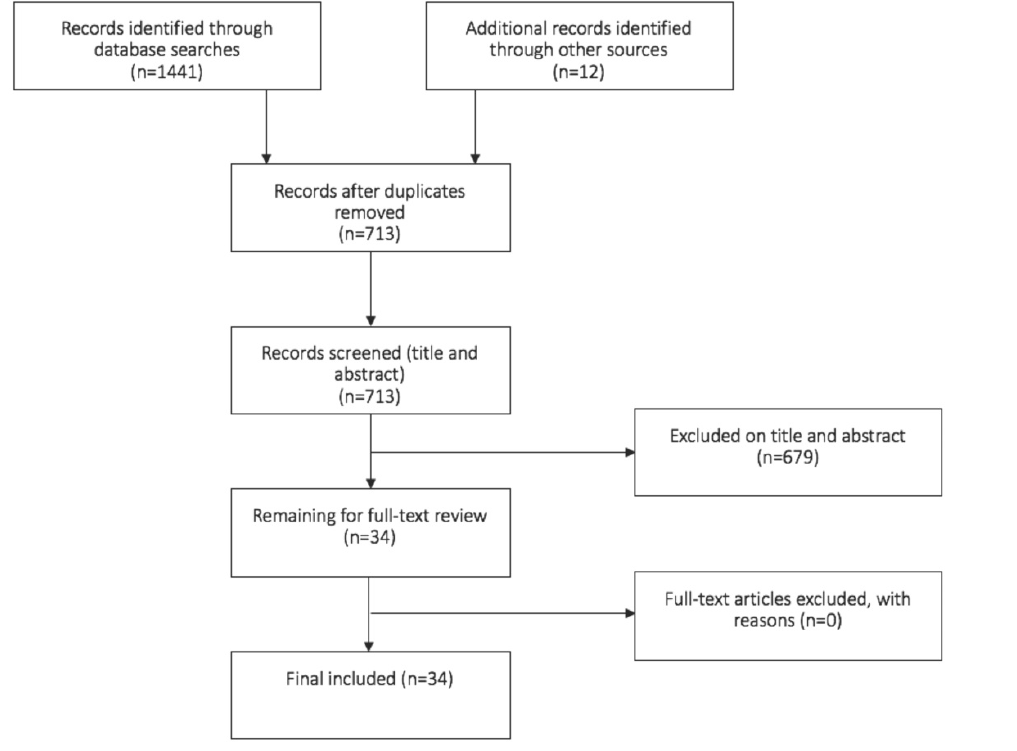
Figure 4: Flowchart of the included